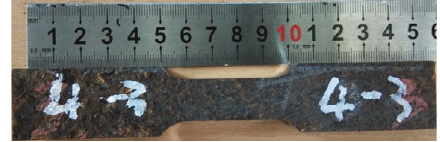
Figure 2: Appearance of a tensile and fatigue